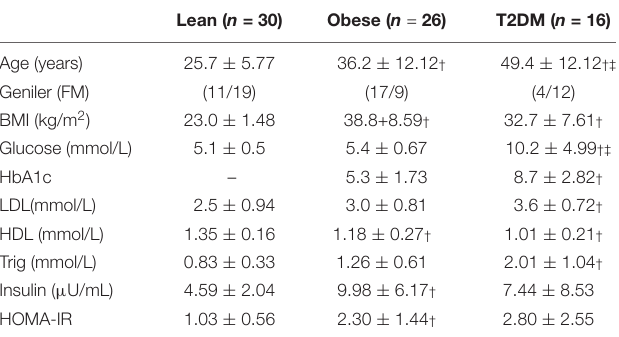
TABLE 1 | Demographic data of study